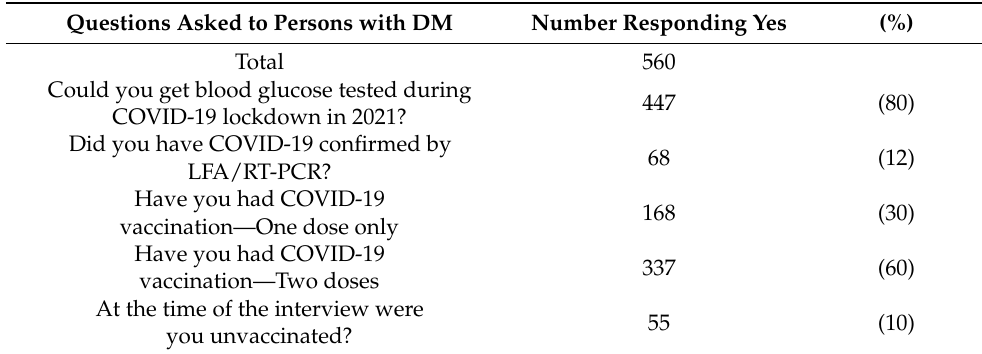
Table 4. COVID-19 related issues in persons with diabetes mellitus attending primary health care facilities, Kerala, India,